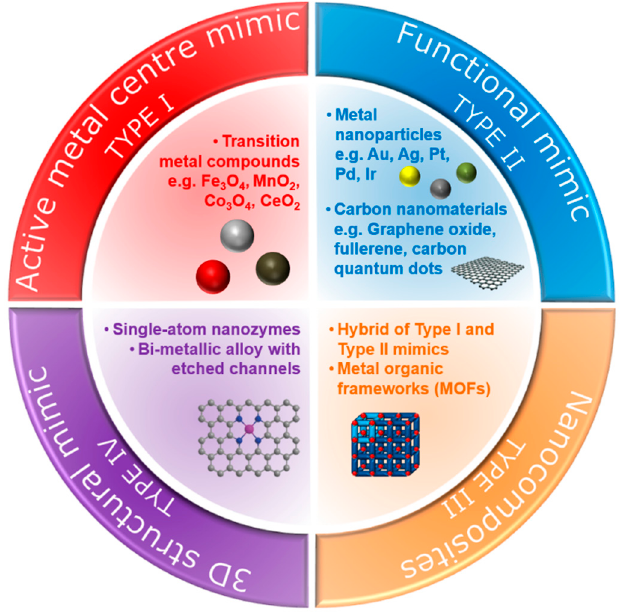
Figure 1. Types of nanozymes based on their mode of natural enzyme-mimicking behaviour.